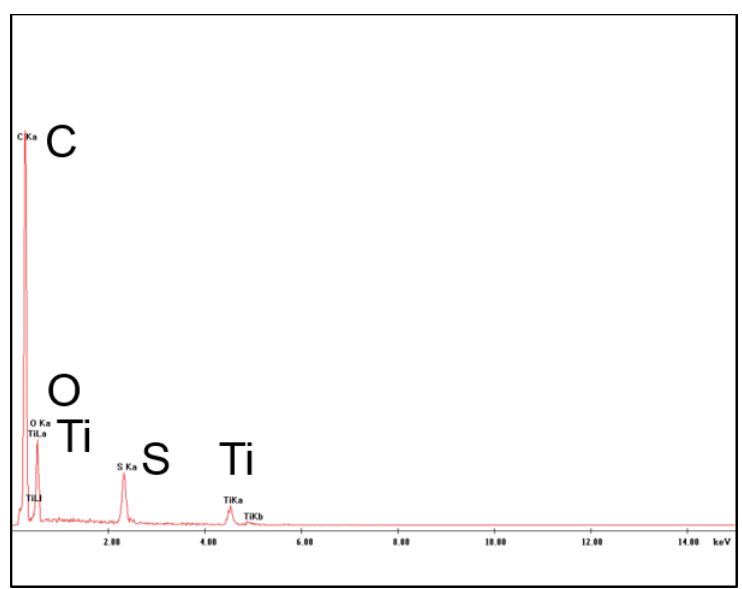
Figure 6. Energy Dispersive X-ray spectroscopy (EDX) analysis of the PES+TiO 2 hollow fibers.